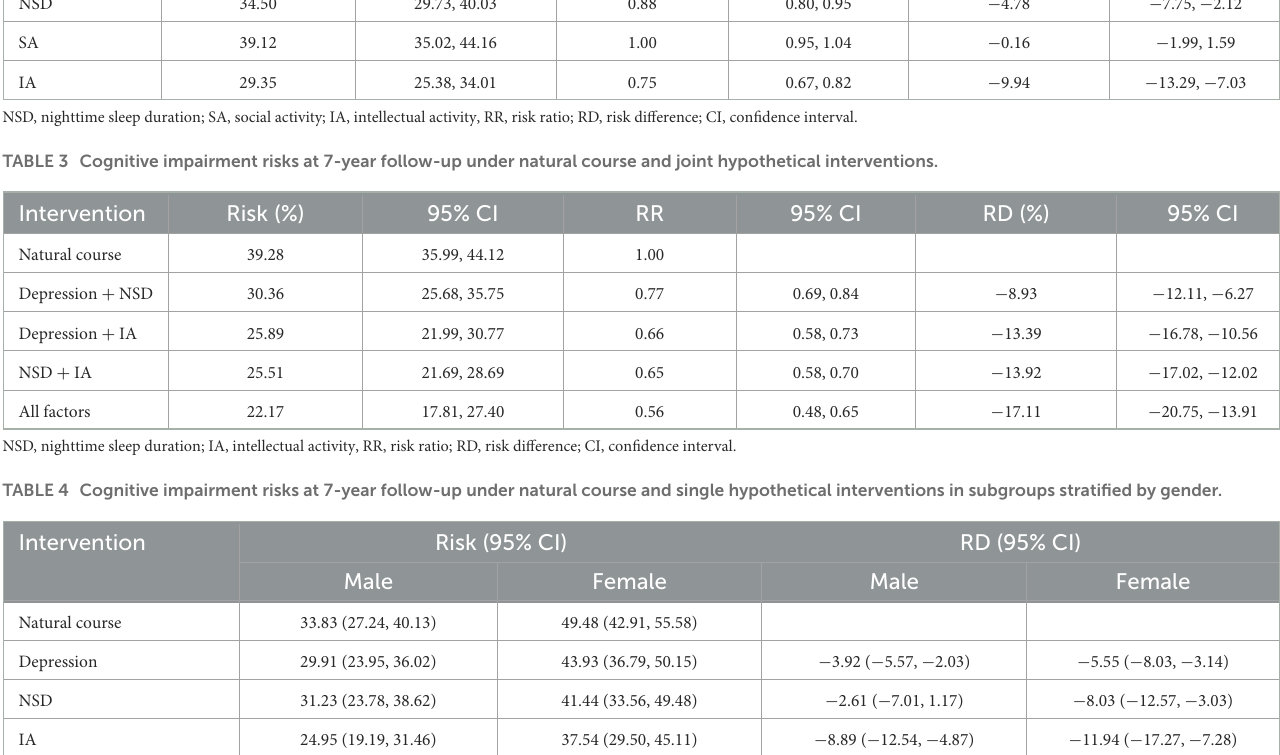
TABLE 2 Cognitive impairment risks at 7-year follow-up under natural course and single hypothetical interventions. Intervention Natural course Depression